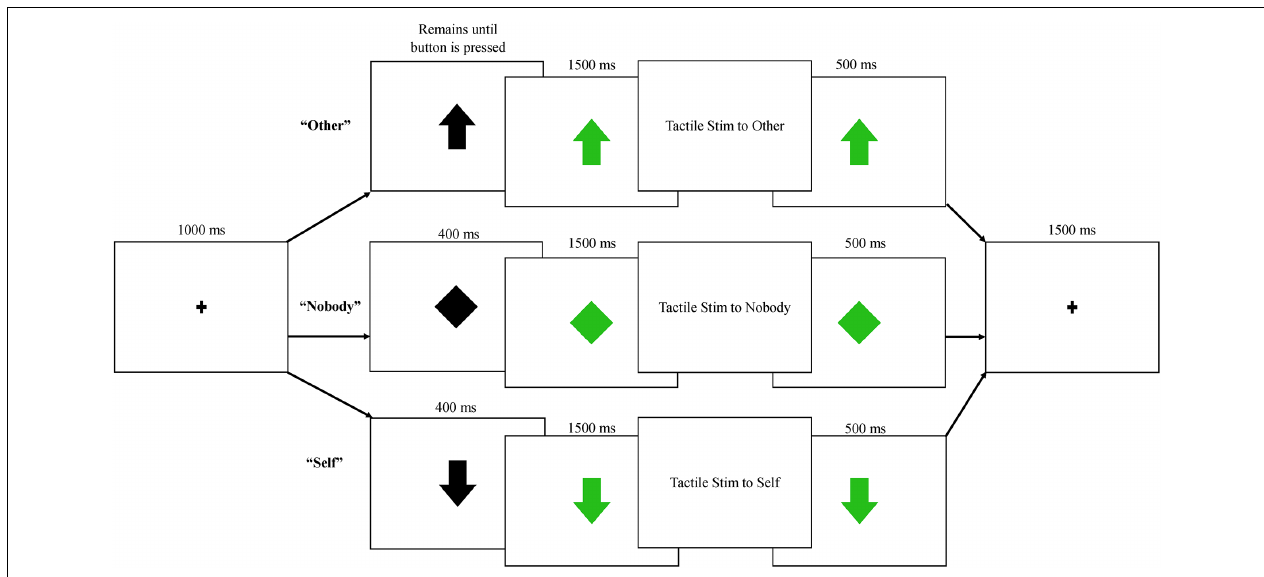
FIGURE 2 | Each trial began with a fixation point, followed by one of three possible trials: other , in which subjects pressed a button and their partner received tactile stimulation; nobody , in which no one pressed a button or received stimulation; self , in which participants were told their partner was pressing a button, triggering tactile stimulation to the participant’s right index finger. All trials were presented equally frequently across human and robot